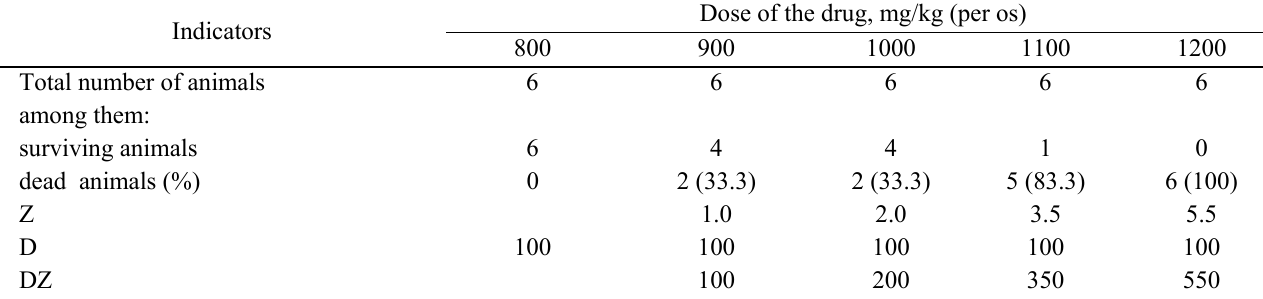
Dose of the drug, mg/kg (per os)